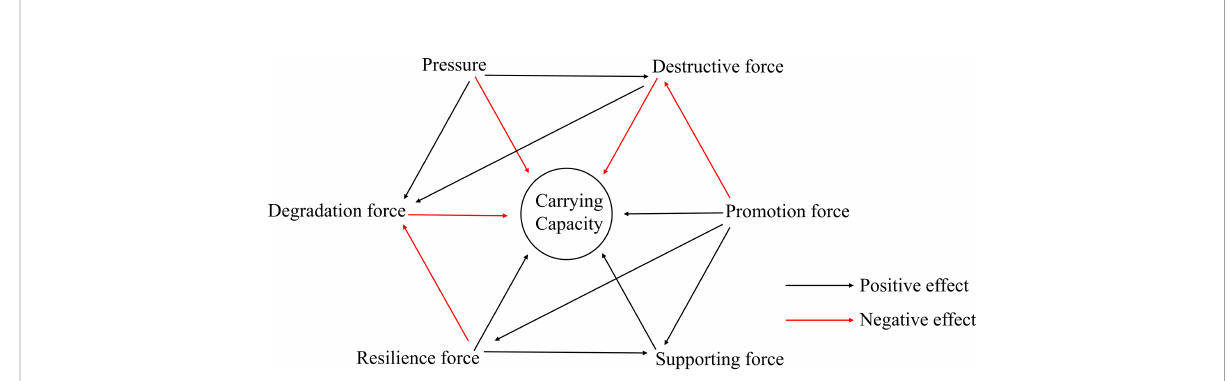
FIGURE 4 The coupling and coordination paths of various forces in the marine resources and environmental carrying capacity.